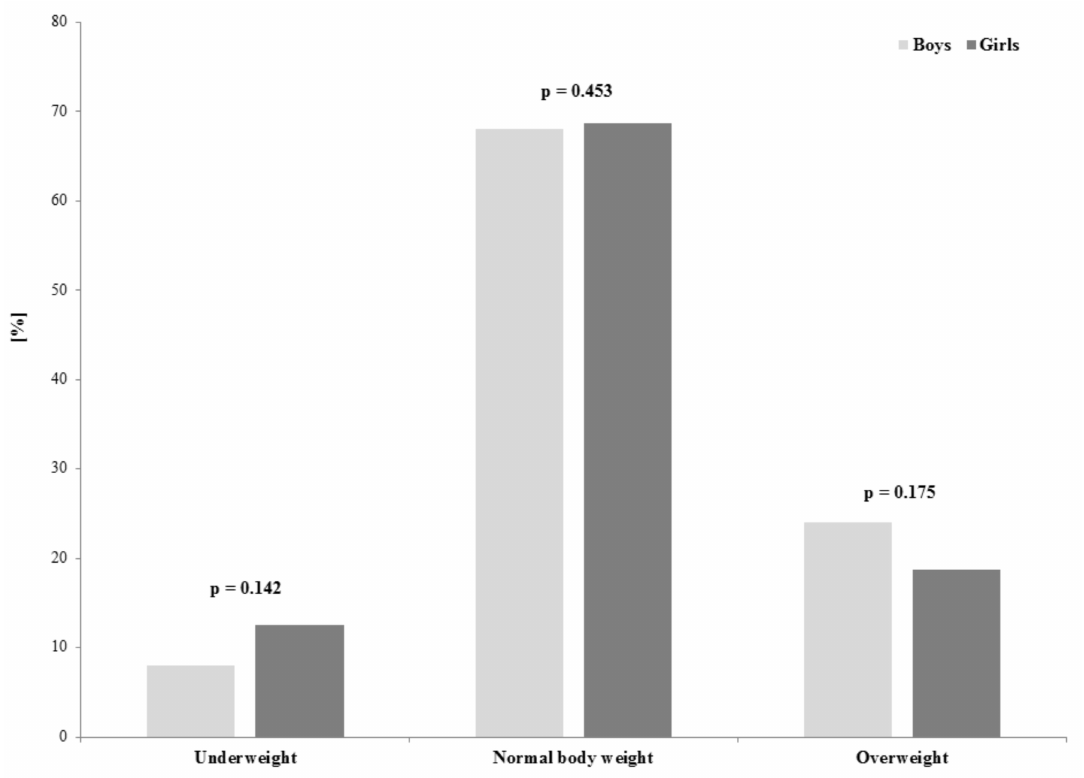
Figure 2. Di ff erences in prevalence of underweight, normal body weight, and overweight in boys and